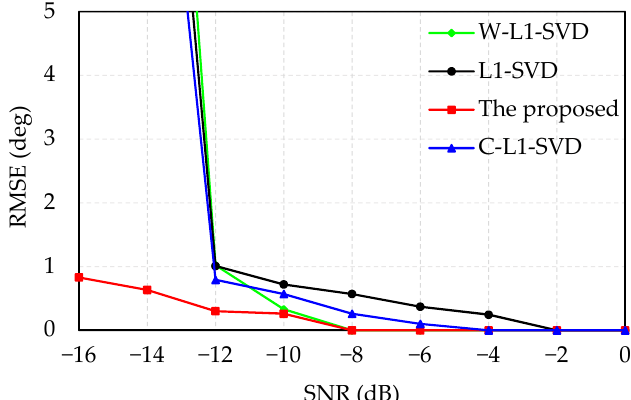
Figure 3. Relationship between SNR and RMSE.